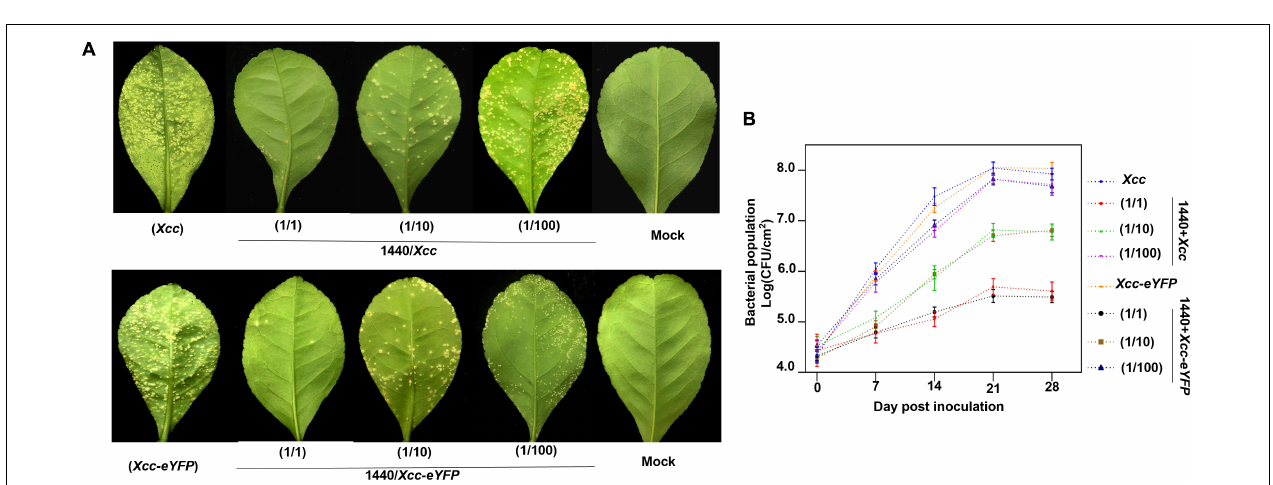
FIGURE 8 | Evaluation of outdoor protective effect of Burkholderia strain-1440 against CBC. (A) CBC symptom development on lemon leaves co-sprayed with Xcc and Xcc-eYFP and Burkholderia strain-1440. Images are representative of four independent replicates at 28 days postinoculation. (B) The bacterial growth curve of Xcc and Xcc-eYFP on the abovementioned leaves using the bacterial counting plate method and fluorescence spot counting method. The values shown are the means of five repeats and SDs. All assays were repeated three times with similar results. Xcc : strain Xcc alone; 1440/ Xcc : (1/1): Burkholderia strain-1440 inoculated simultaneously with Xcc at the ratio of 1–1; (1/10): Burkholderia strain-1440 spray-inoculated simultaneously with Xcc at the ratio of 1–10; (1/100): Burkholderia strain-1440 spray-inoculated simultaneously with Xcc at the ratio of 1–100. Xcc-eYFP : Xcc-eYFP spray-inoculated alone; 1440/ Xcc-eYFP : (1/1): Burkholderia strain-1440 inoculated simultaneously with Xcc-eYFP at the ratio of 1–1; (1/10): Burkholderia strain-1440 inoculated simultaneously with Xcc-eYFP at the ratio of 1–10; (1/100): Burkholderia strain-1440 inoculated simultaneously with Xcc-eYFP at the ratio of 1–100; Mock: ddH 2